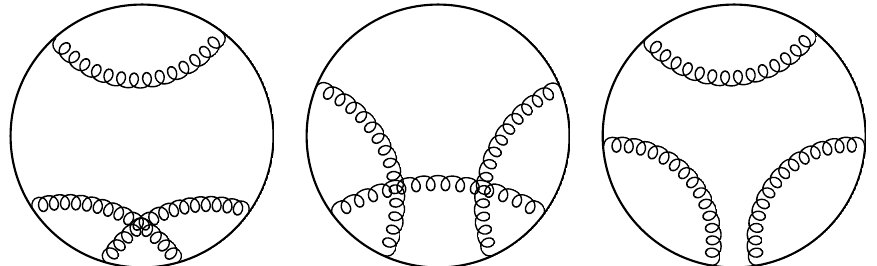
Figure 2. Various examples of chord diagrams: the (cid:12)rst one is a generic gluon diagram, they contribute to h W i at (cid:12)nite N . For k gluons, by Wick’s theorem there are (2 k (cid:0) 1)!! such diagrams. R The second one is a connected chord diagram. They contribute to ln h W i by the recursion relation (4.12). The last diagram is a fully disconnected chord diagram. These are the diagrams that contribute to the planar limit of h W i [40]. For k gluons, there are C k = (2 k )! of them.